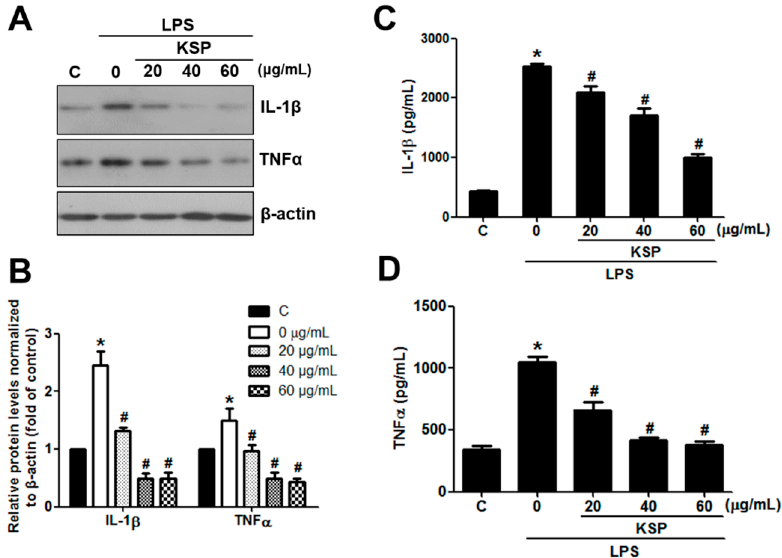
Figure 4. Secretion of IL-1 β and TNF α inhibited by KSP in LPS-stimulated RAW 264.7 cells. ( A , B ) RAW 267.4 cells were pretreated with KSP (0, 20, 40, 60 µ g/mL for 12 h) and then stimulated with LPS (1 µ g/mL for 1 h) with KSP withdrawing. Protein was extracted and subjected to immunoblotting for IL-1 β , TNF α and β -actin. Western blots were representative of three independent experiments; ( C , D ) The levels of IL-1 β and TNF α were determined in the culture medium using ELISA kits. Data was analyzed by ANOVA followed by Student’s t test. Vertical bars represent the standard error from the means of three separate tests. * p < 0.05 vs. control, # p < 0.05 vs. LPS without KSP.